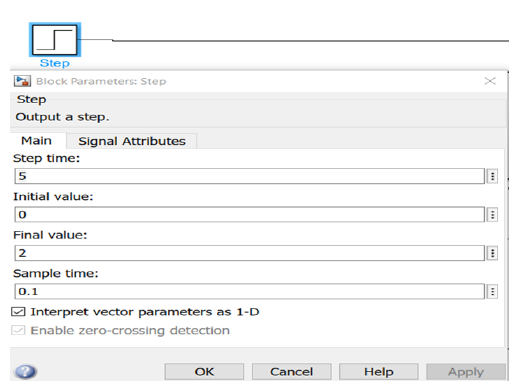
Figure 6. The parameter of step block